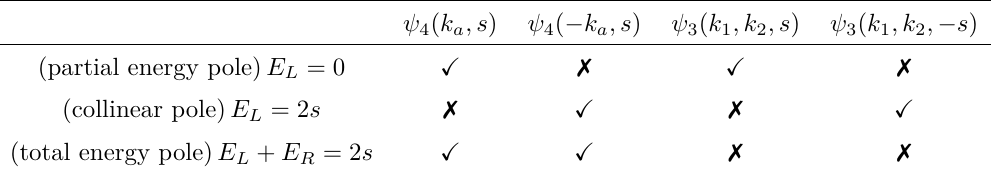
Table 1 . Singularities of the elements apearing in the 4 -point exchange COT. The same applies to E R singularities as well with the substitution ψ 3 ( k 1 , k 2 , s ) → ψ 3 ( k 3 , k 4 , s )